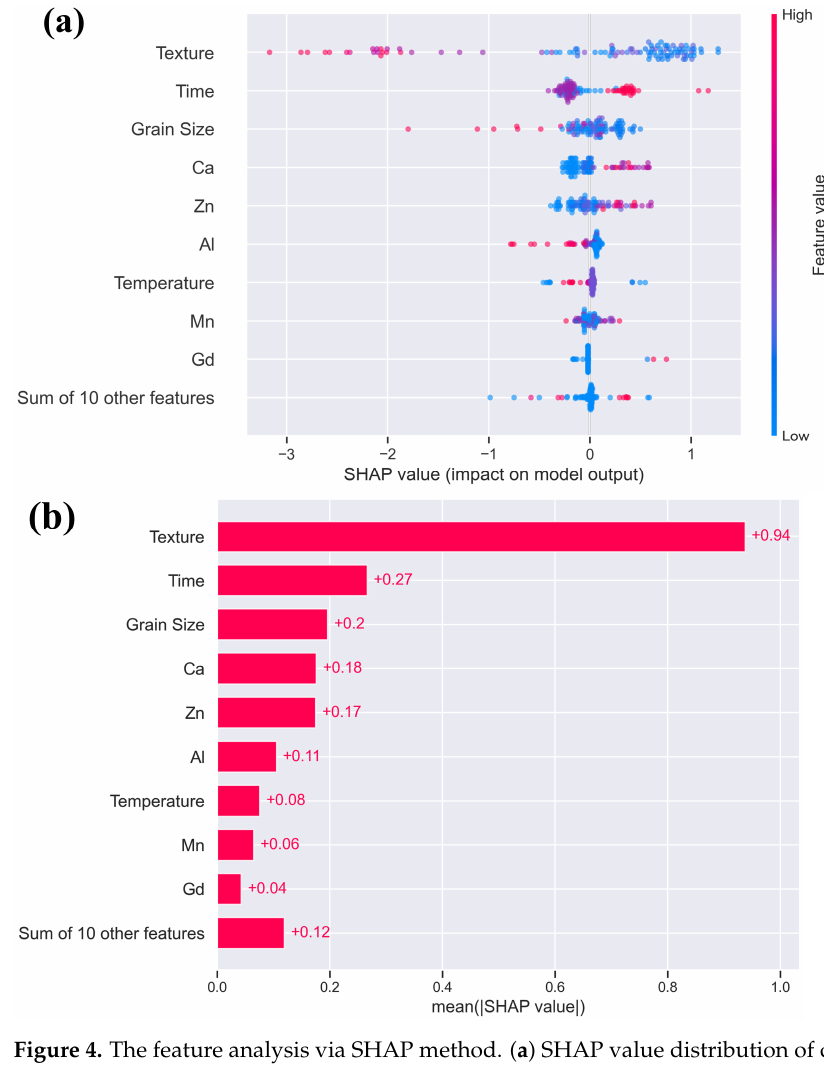
size and the content of Al has an inverse relationship with the SHAP value; however, the